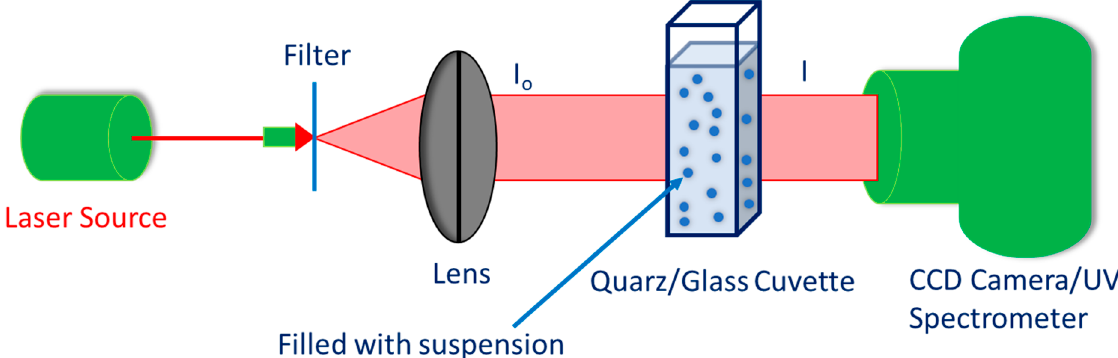
Figure 5. Scheme of transmittance/absorbance measurement.